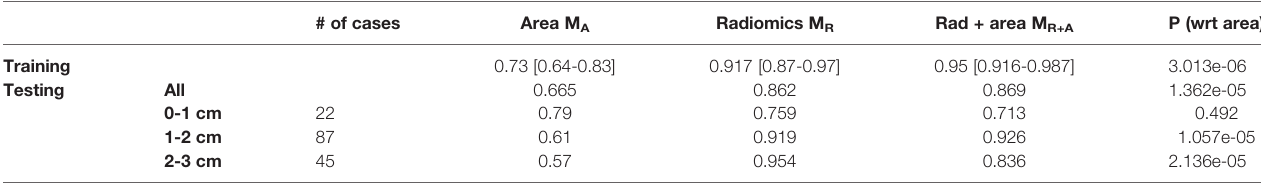
TABLE 2 | AUC comparison for logistic regression model trained with tumor area M A , radiomic features, M R and combined radiomic and area based models, M R+A . P-value is calculated to observe the added bene fi t of tumor area in the radiomics model, M R .